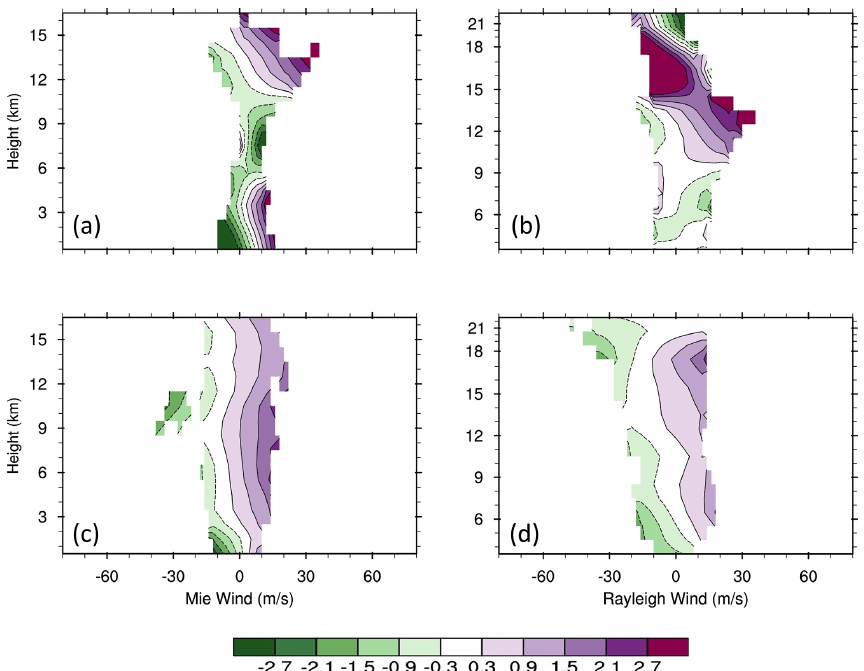
Figure 13. Vertical distributions of average TLS estimated biases (color scale; ms − 1 ) for Mie (a, c) and Rayleigh (b, d) winds as a function of Aeolus winds (ms − 1 ) in the latitudinal bands centered at the Equator (a, b) and at 80S (c, d) for the descending orbits.